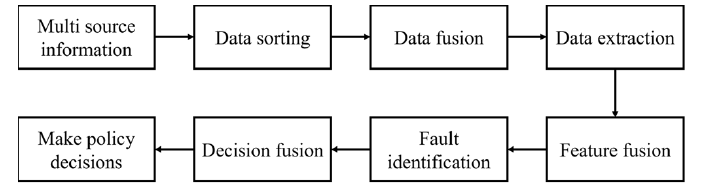
Figure 1. Multi-source information fusion process.